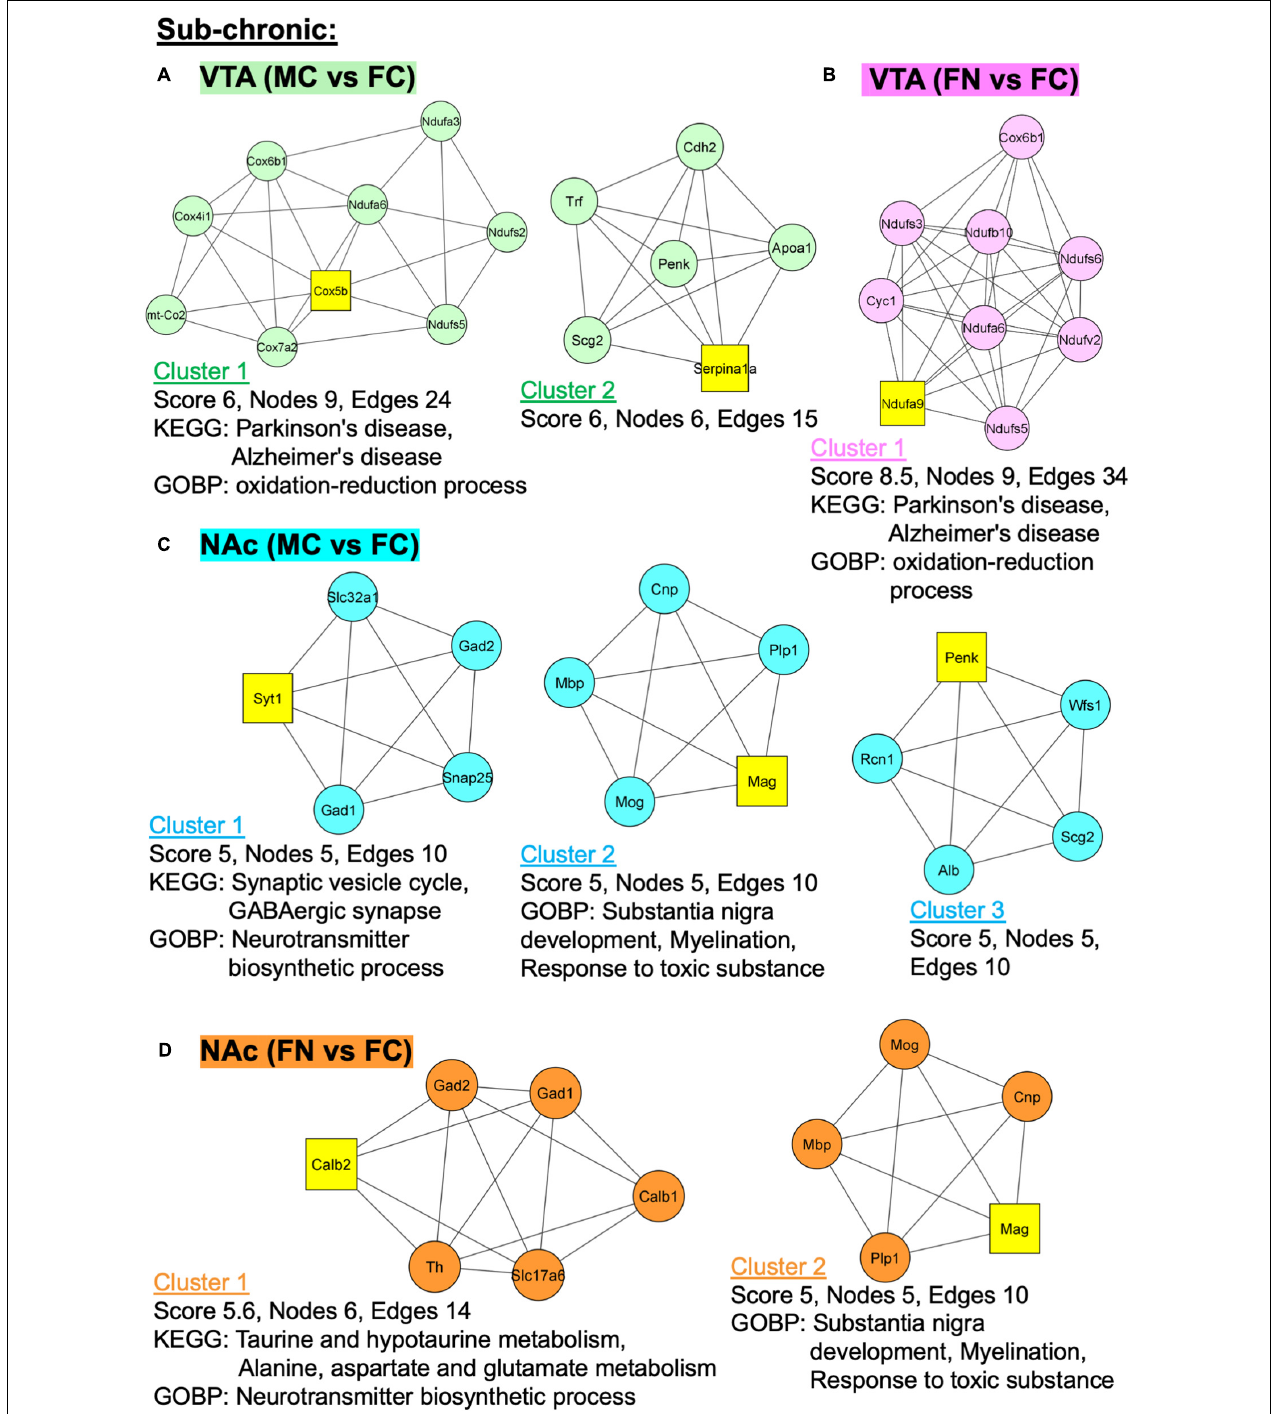
FIGURE 6 | Protein–protein interaction (PPI) network analysis of differentially expressed proteins with and without sub-chronic nicotine. PPI network construction was performed using the STRING database for sex and treatment group comparisons with sufficient numbers of differentially regulated proteins for analysis. Thresholds for analysis were set at an interaction score of > 0.7 and FDR of 1%. Further sub-network analysis was performed using the MCODE plug-in in Cytoscape (cut off-values: node score = 0.2, degree = 4, k-core = 4, maximum depth = 100). The top three ranked clusters of networks, or fewer if less than three were identified, are shown. Score, number of nodes, number of edges, and significantly enriched GO and KEGG pathways ( p < 0.05) as analyzed using DAVID database are shown for each cluster. (A) Two clusters were identified for MC vs. FC in the VTA of C3H/HeJ mice used for sub-chronic nicotine administration. (B) Only one cluster was identified for FN vs. FC in the VTA after sub-chronic nicotine administration. (C) The top three clusters are shown for MC vs. FC in the NAc shell of C3H/HeJ mice used for sub-chronic nicotine administration. (D) Two clusters were identified for FN vs. FC in the NAc shell after sub-chronic nicotine administration.